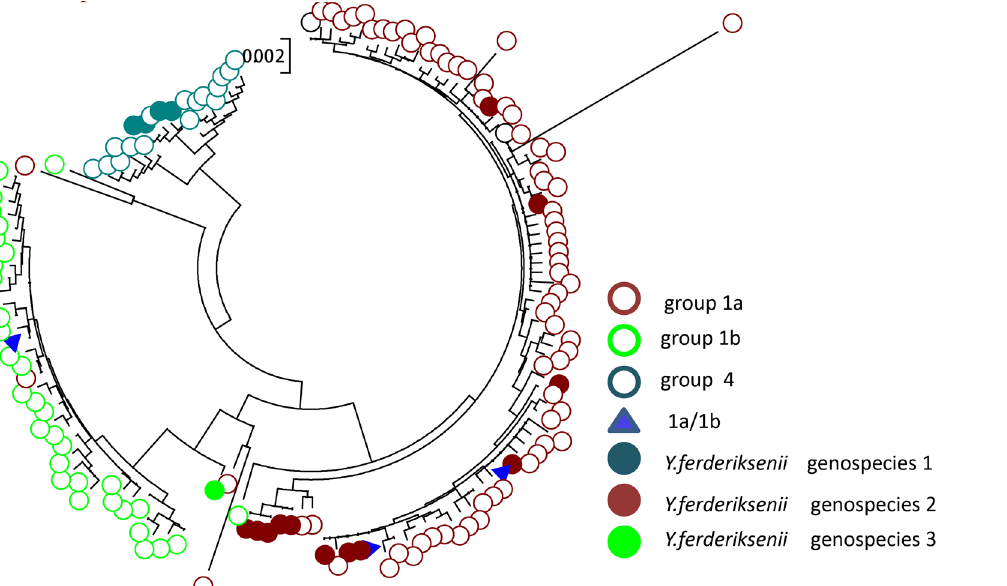
Fig 3. Phylogenetic tree based on single 16S rRNA gene from Y . ferderiksenii / intermedia strains in group 1a, 1b, and 4 and strains of Y . ferderiksenii belonging to three geno-species. Hollow circles represent all 16S rRNA gene types of Y . ferderiksenii / intermedia strains in group 1a, 1b, and 4; while solid circles represent Y . ferderiksenii s trains of three geno-species [1]. Triangles represent identical 16S rRNA gene patterns of strains in group 1a and group 1b.